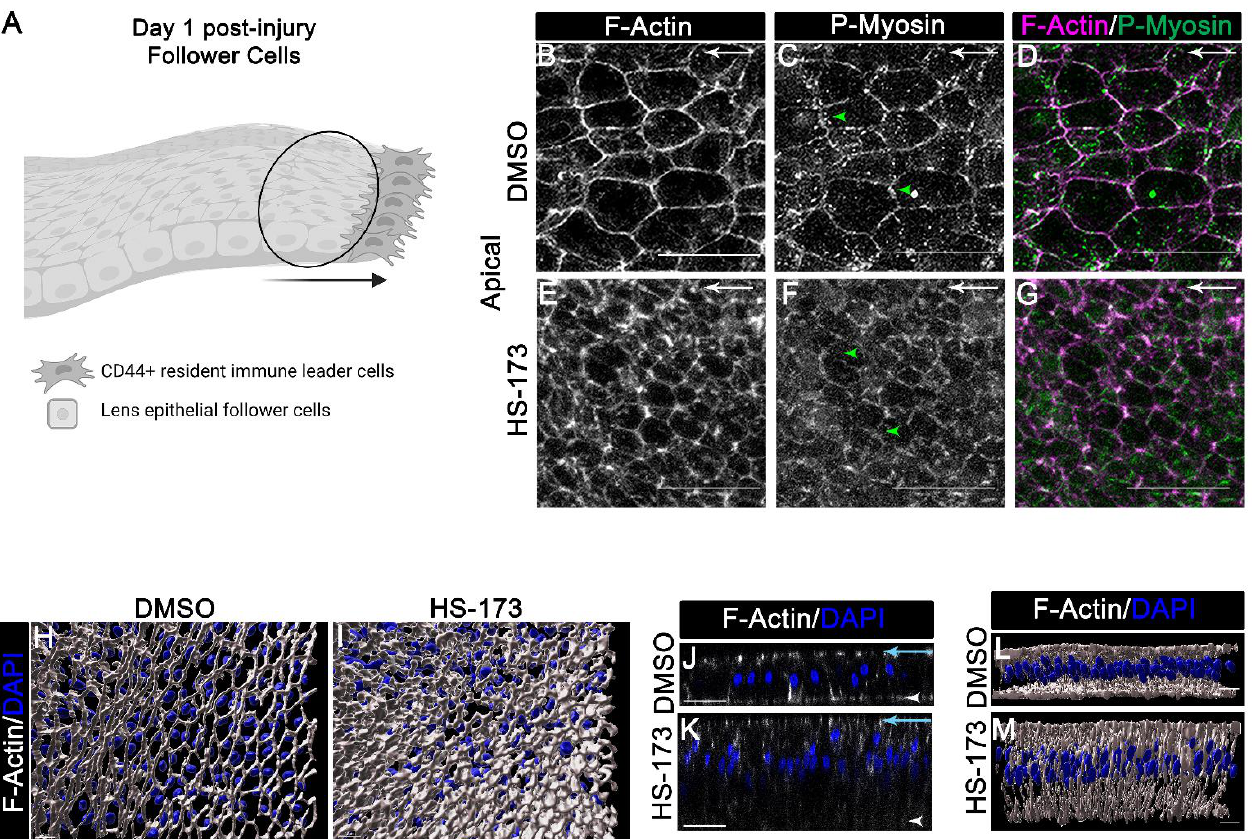
Figure 5. Impact of blocking p110 α on the apical organization of the wounded lens epithelial follower cells post-injury. ( A ) Model of CMZ highlighting our region of interest (follower cells, black circle) for these studies. ( B – M ) Ex vivo post-cataract surgery explants were treated with vehicle control or HS-173 to inhibit p110 α from Time 0 for 24 h (Day 1 post-injury). Cultures were labeled with phalloidin to identify filamentous actin (F-actin, white ( B , E ), purple ( D , G )) and immunolabeled for active myosin (p-myosin, white ( C , F ), green ( D , G )). ( B – G ) Confocal images of follower cells focused apically revealed a cortical distribution of actomyosin at cell–cell border with vehicle and HS-173 treatment. However, HS-173 treatment revealed differences in active myosin distribution at apical vertices (see arrowheads) and a more compact organization of the monolayer compared to vehicle control ( E , G ). 3D structures from confocal z-stacks, which were labeled for F-actin (white) and nuclei (DAPI, blue) were created to allow the better visualization of the compact organization of wounded epithelial follower cells with HS-173 and vehicle treatment ( H , I ). ( J , K ) Orthogonal views from confocal z-stacks of cultures labeled for F-actin (white) and nuclei (DAPI, blue) were created to reveal height differences in the wounded epithelial cells of HS-173 vs. DMSO-treated cultures. ( L , M ) 3D structures of orthogonal views were created from the same region in ( J , K ) to further highlight shape differences. Magnification bars = 20 µ m ( B – G , J , K ) or 5 µ m ( H , I ). ( B – G ) arrows show direction of cell